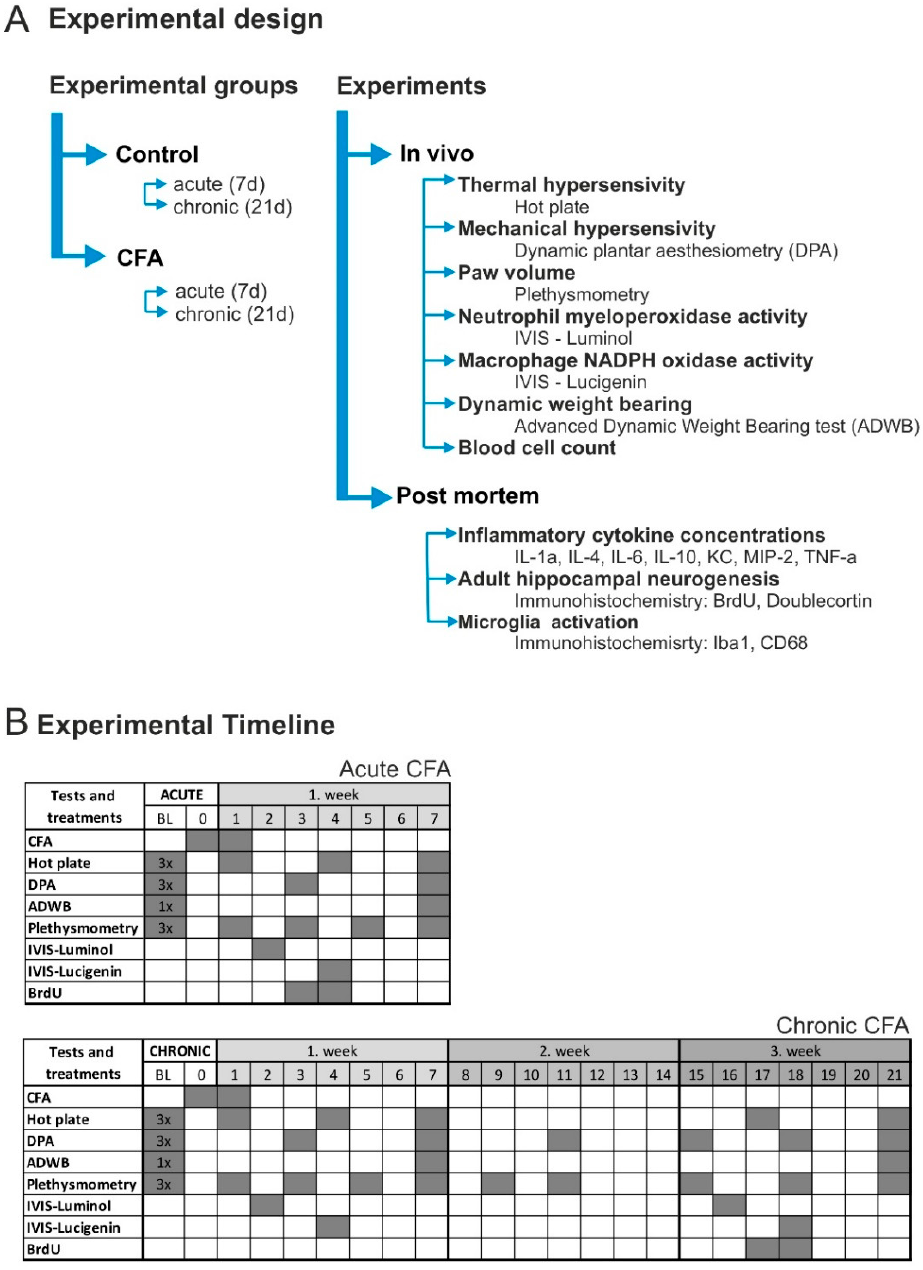
Figure 1. Experimental design and experimental timeline. ( A ) Mice were randomly divided into four groups: Acute Control; Chronic Control; Acute CFA and Chronic CFA ( n = 20/group). Various behavioral, physiological and histopathological studies were carried out to characterize the conse- quences of acute and chronic CFA-induced arthritis. ( B ) The experimental schedules for the Acute CFA- and Chronic CFA-treated animals, as well as their corresponding controls. Behavioral tests, in vivo imaging and treatments were performed on those days which have gray background. Ab- breviations: advanced dynamic weight bearing (ADWB); baseline (BL); complete Freund’s adjuvant (CFA); dynamic plantar aesthesiometry (DPA).